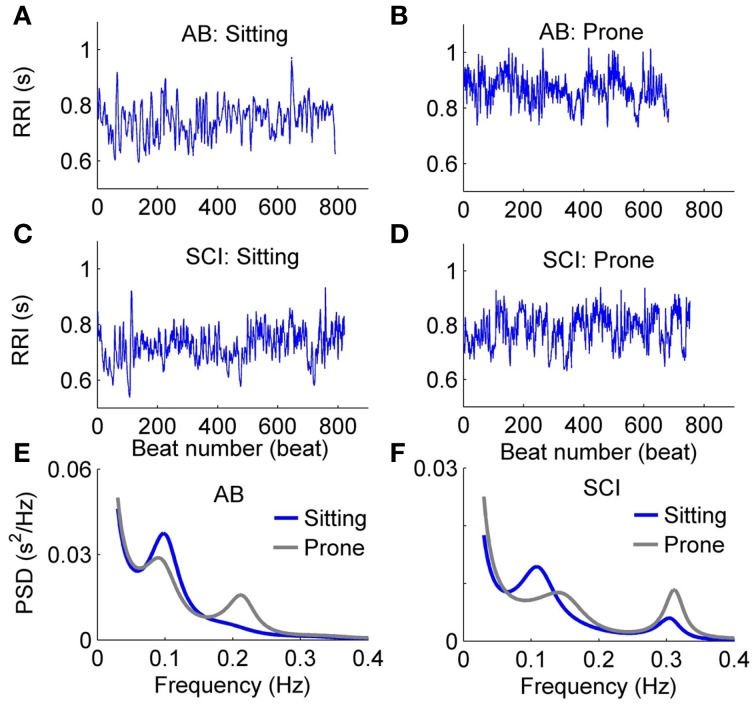
Typical examples of changes in RRI and PSD of HRV in response to the postural change in an able-bodied control (A,B,E) and a patient with SCI (C,D,F).